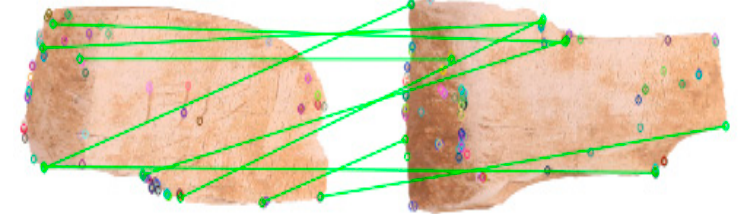
Figure 6. Traditional ORB feature matching.